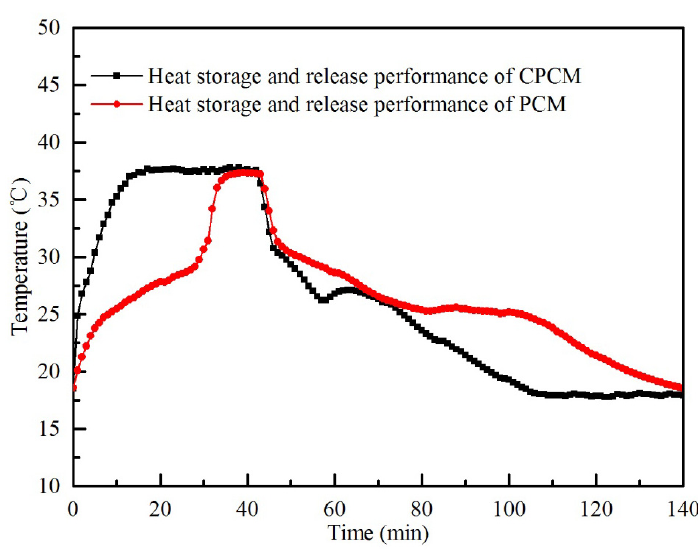
Figure 7. The heat storage and release performances of the phase change material (PCM) and its